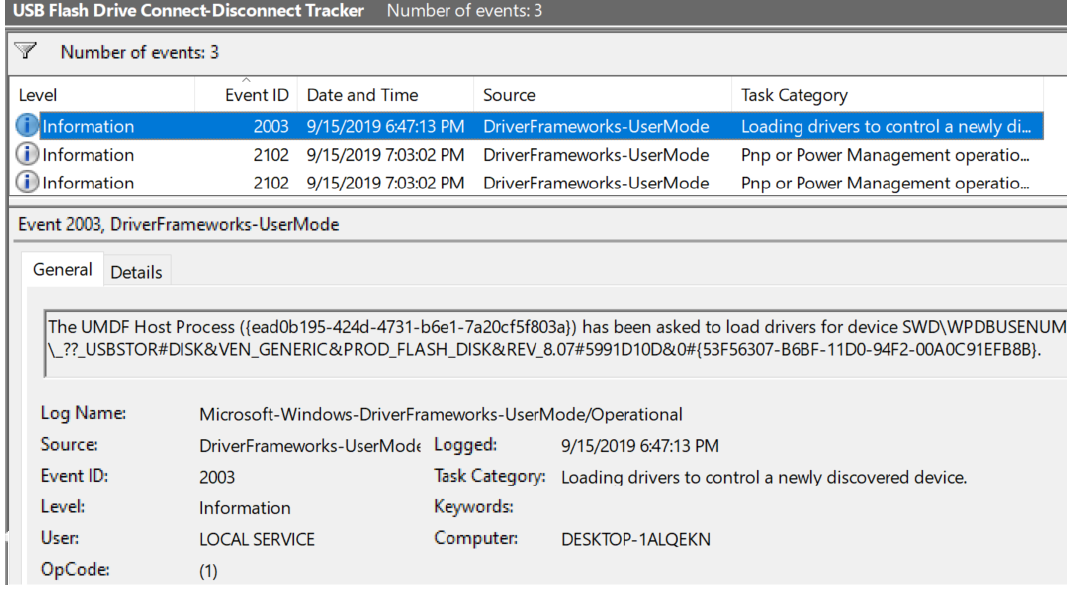
Figure 11. Custom view for event IDs.